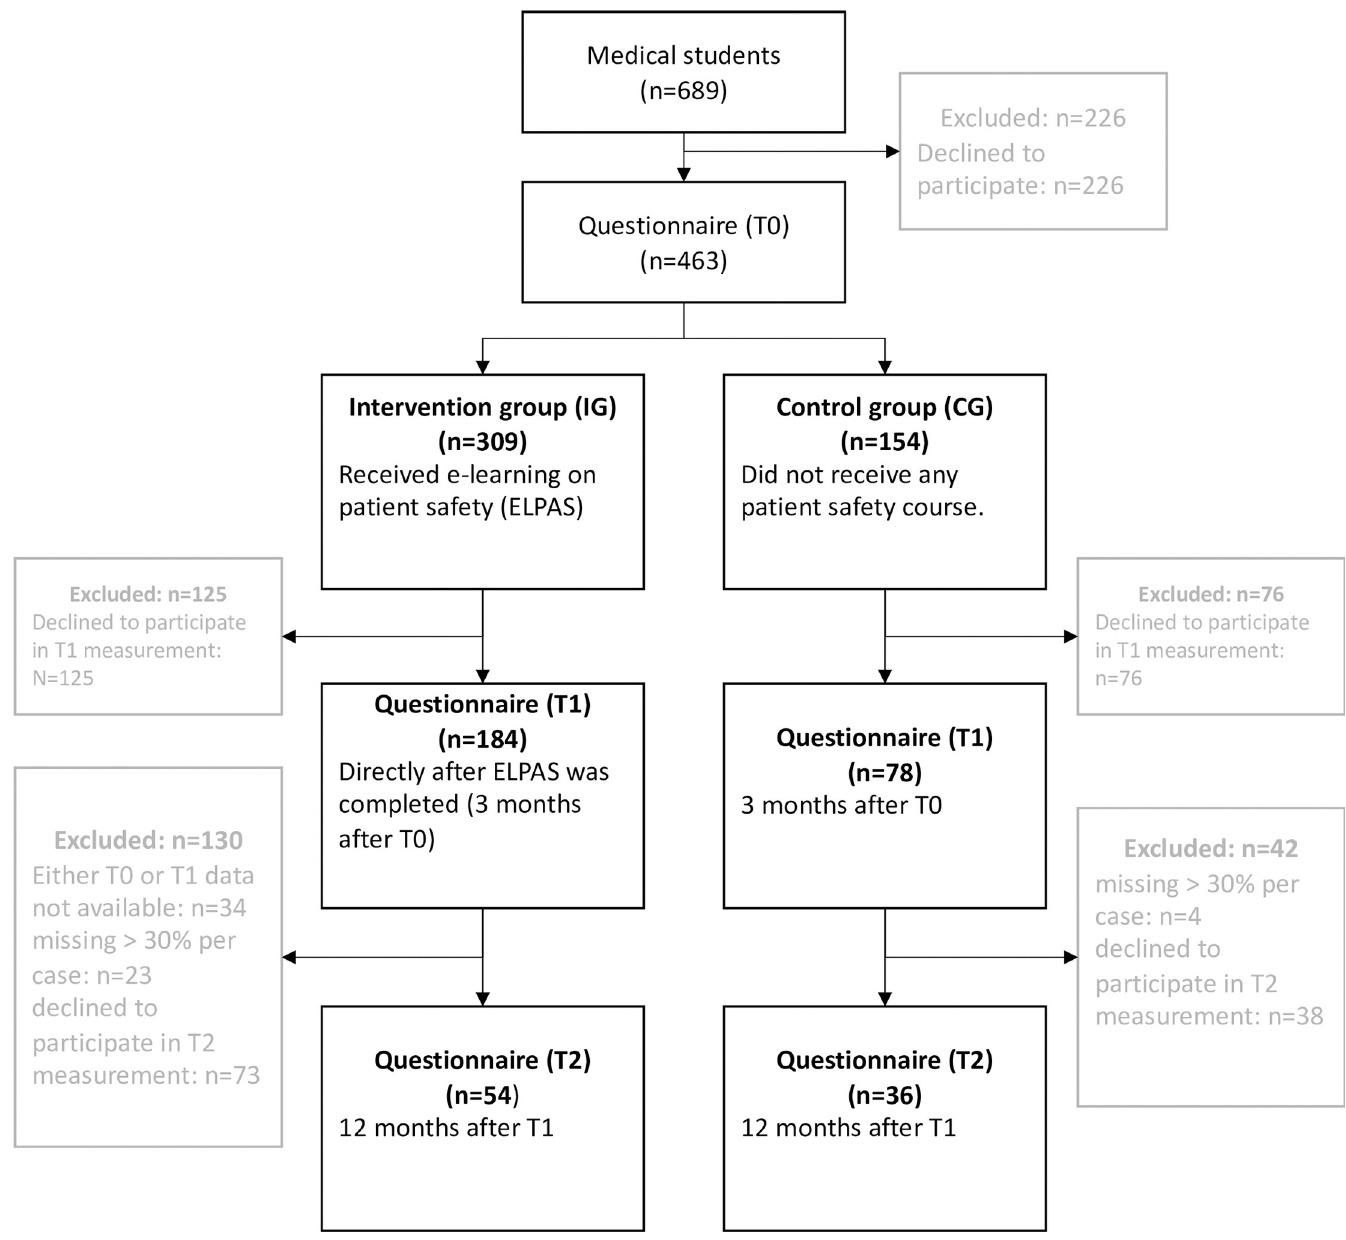
Fig 1. Summary of method and